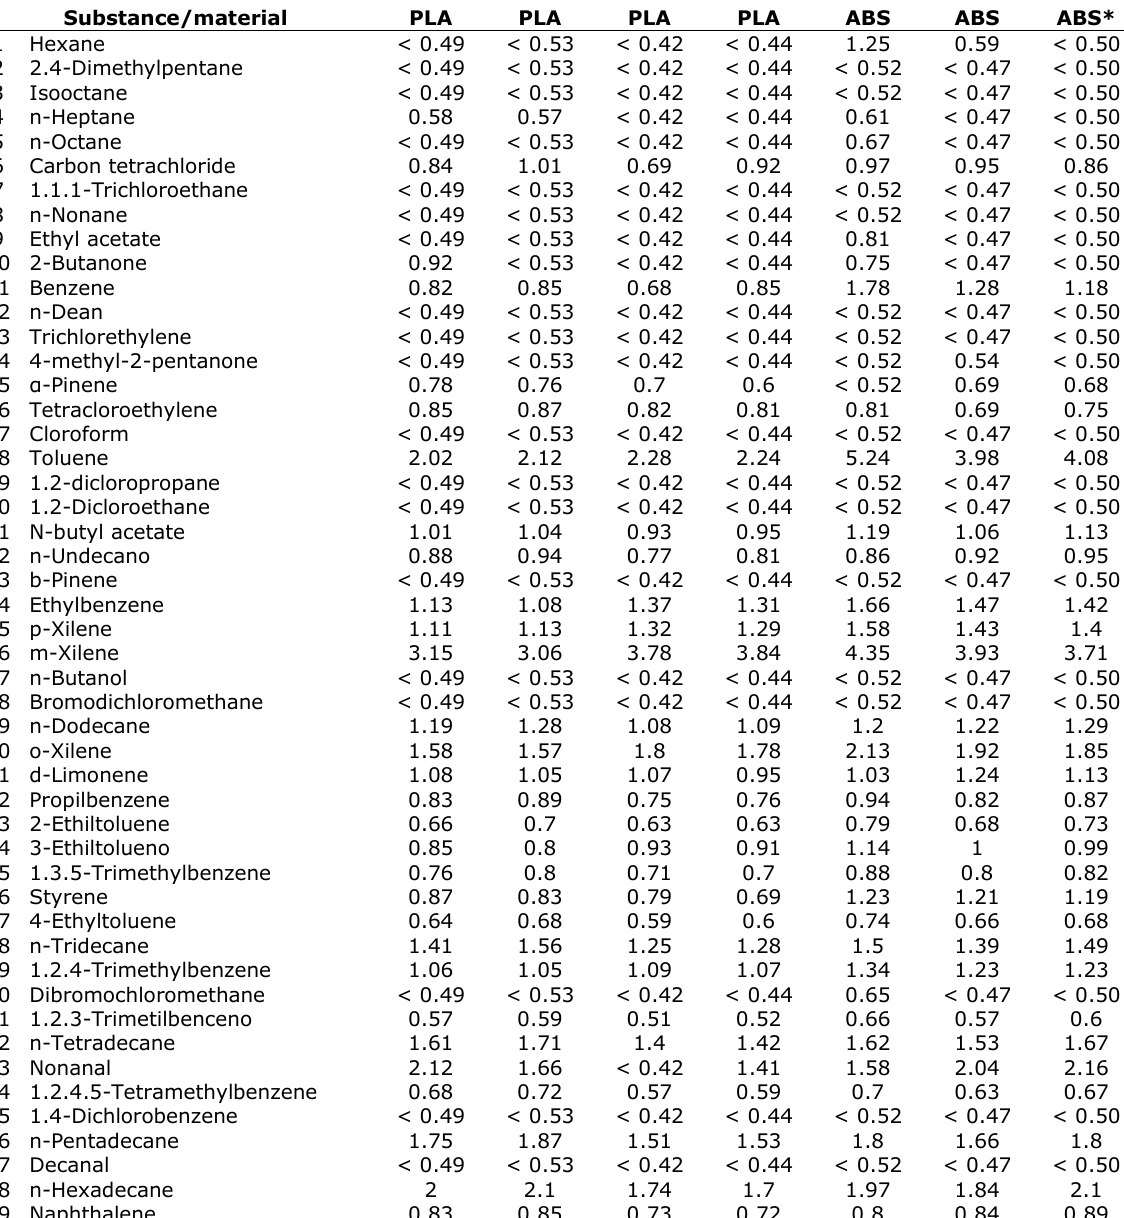
Table 5. VOCs emission rates ( μ g/m 3 ) during 3D printing with different filaments